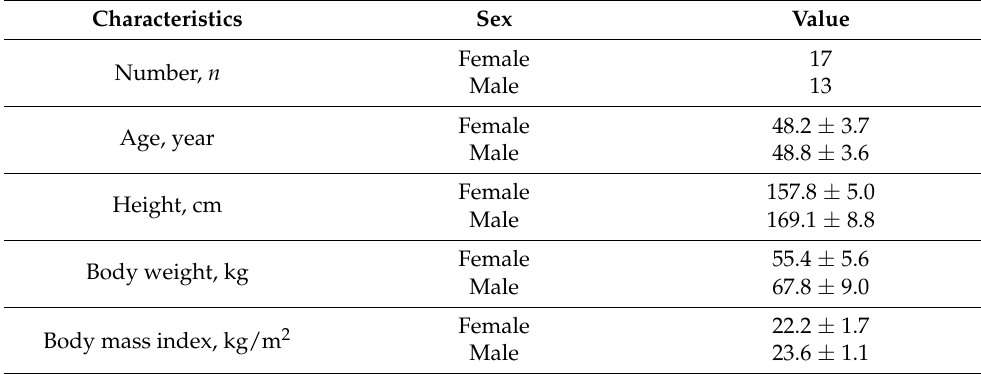
Table 2. Characteristics of the participants in the present study.